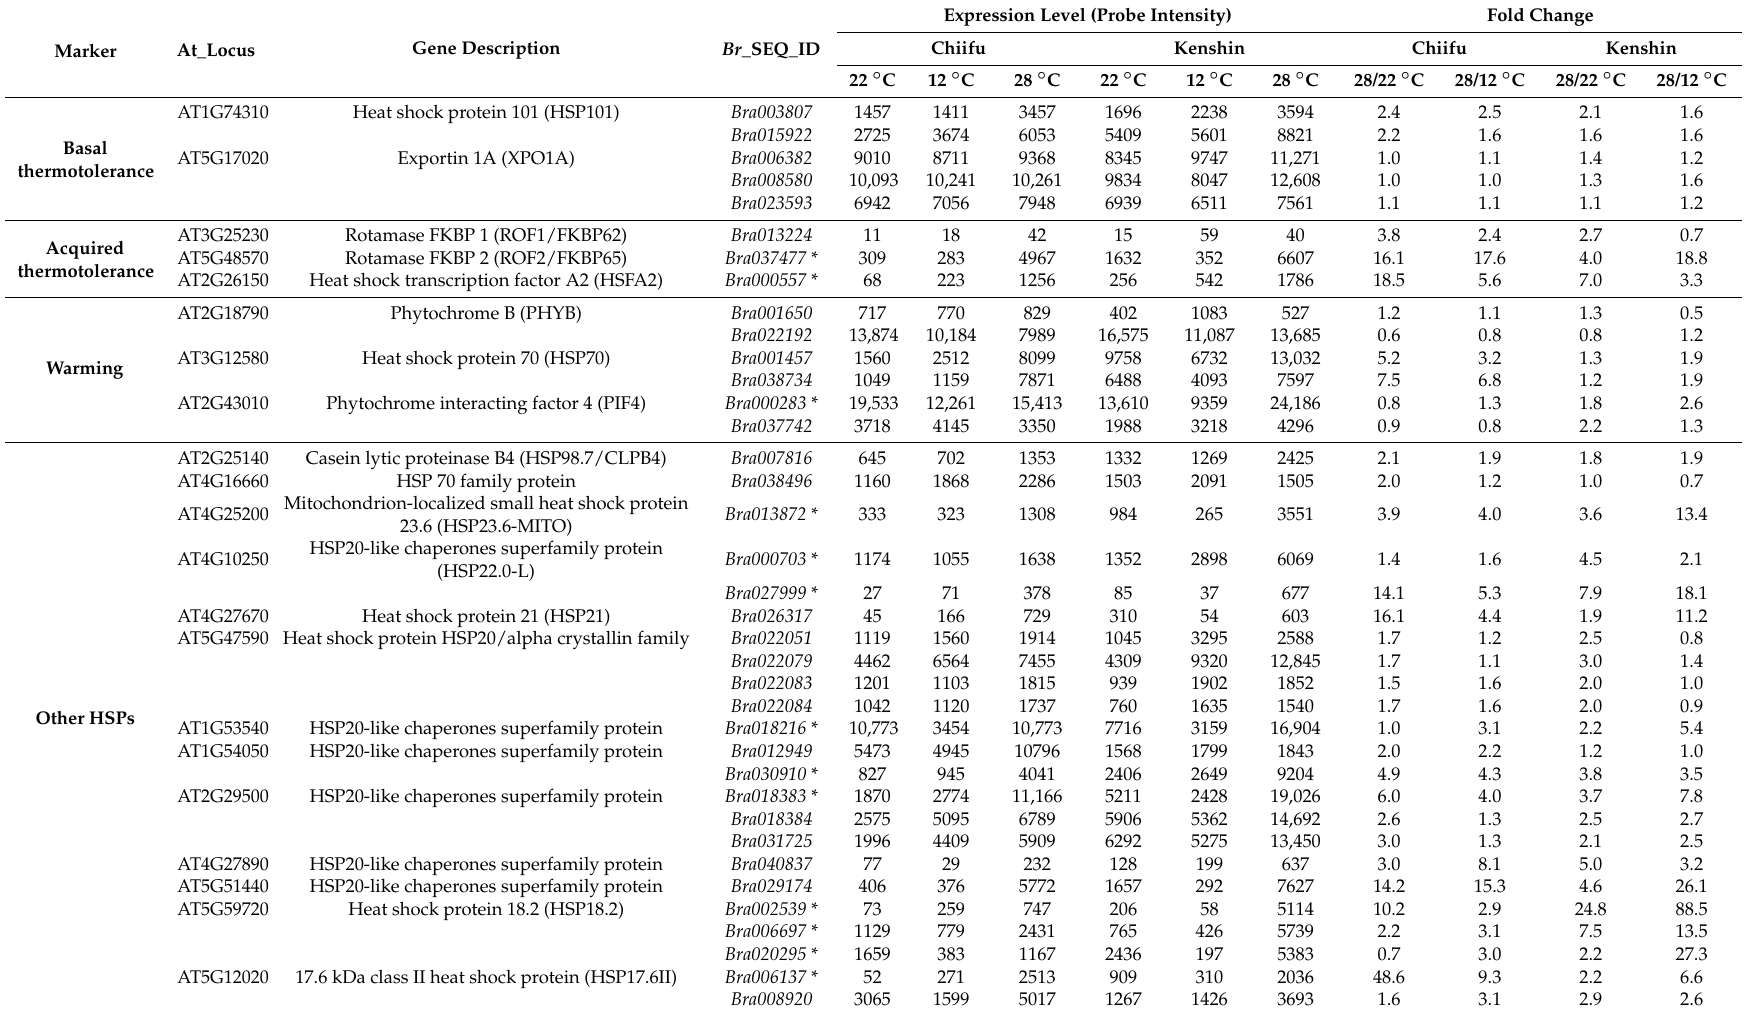
Table 4. Summary of the expression levels of B. rapa genes shown to be HT responsive in Arabidopsis